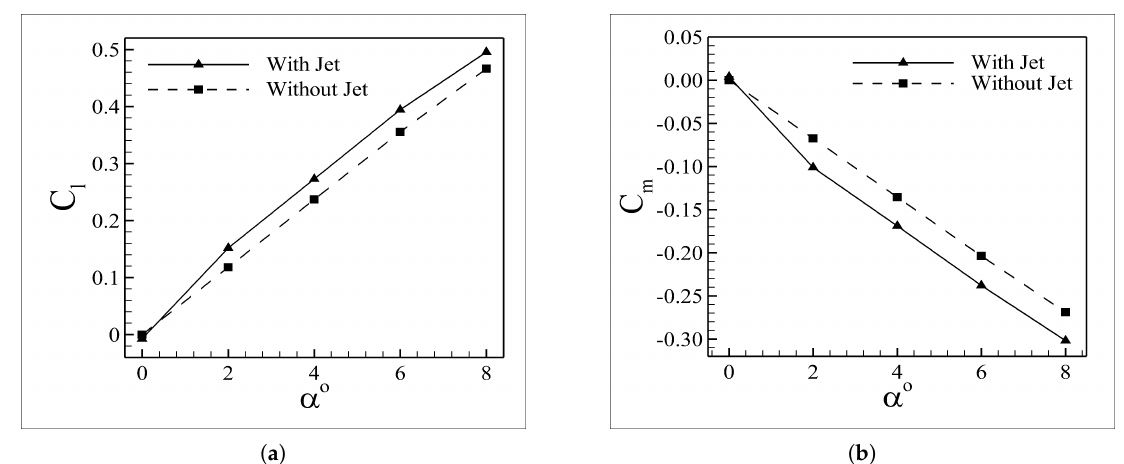
Figure 14. Effects of opposing jet on the lift and moment coefficients of airfoil by increasing the static angles of attack ( α = 0 ◦ to 8 ◦